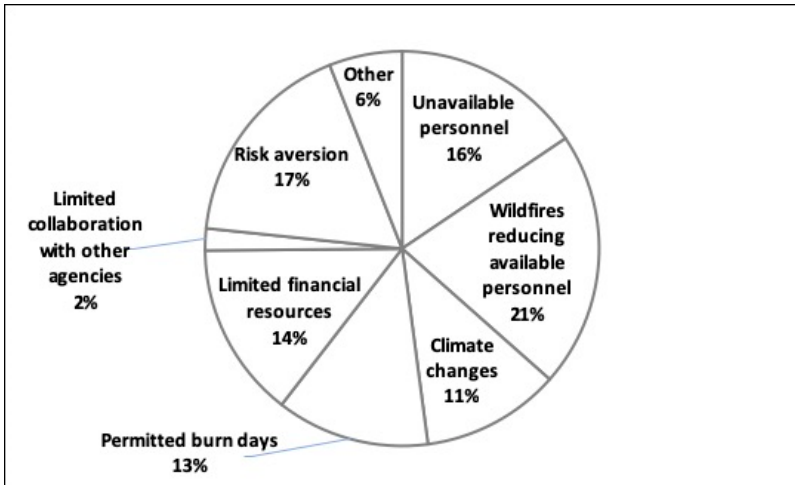
Figure 2. Top Three Burn Window Constraints. Fire managers were asked to rank the top three constraints to their agency’s burn window. Responses were not weighted and were totaled. Other responses included National Environmental Policy Act procedures, ecological objectives, and endangered species, limited available contractors and specialists, and air quality permits.